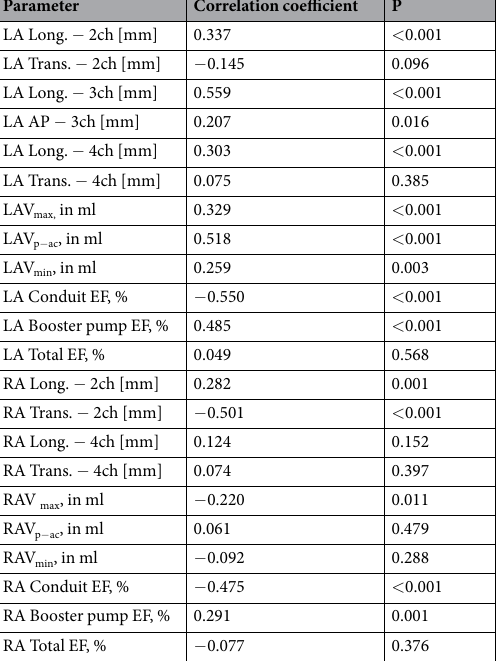
Table 8. Correlation between age and atrial parameters (all volume parameters were measured by the short axis method) (n = 135). Long., Longitudinal dimension; Trans, Transverse dimension; AP, Antero-posterior dimension; 2ch, 2-chamber view; 3ch, 3-chamber view; 4ch, 4-chamber LAV max, maximal left atrial volume; LAV p − ac , left atrial volume before atrial contraction; LAV min, minimal left atrial volume; LA Conduit EF, Conduit left atrial emptying fraction; LA Booster EF, Booster left atrial emptying fraction; LA Total EF, total left atrial emptying fraction. RAV max , maximal right atrial volume; RAV p − ac , right atrial volume before atrial contraction; RAV min , minimal right atrial volume; RA Conduit EF, Conduit right atrial emptying fraction; RA Booster EF, Booster right atrial emptying fraction; RA Total EF, total right atrial emptying fraction.